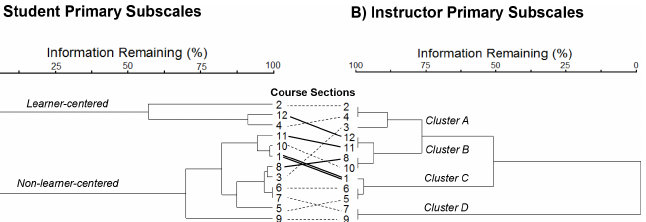
Fig 3. Twelve introductory biology course sections independently clustered by student and instructor primary subscales. In the dendrogram, information remaining (%) is indicative of the strength of the relationship between class sections; clusters joined with greater information remaining are more closely related. Sections are clustered by student perceptions in the dendrogram to the left (a), while the same sections are clustered by instructor perceptions in the right dendrogram (b). Identical course sections are connected in the center to aid in visualization of similarities; connector lines patterns denote enrollment size (dashed line (cid:20) 70 students, solid line = 71–150 students, bolded double line > 150 students [one section, n = 391]). In the instructor dendrogram, Cluster A is the true learner-centered cluster; Cluster B is characterized by internal confusion within individual faculty; Cluster C is epitomized by the conflict in perspectives among groups; and Cluster D is the non-learner-centered cluster based on instructor and student perceptions.